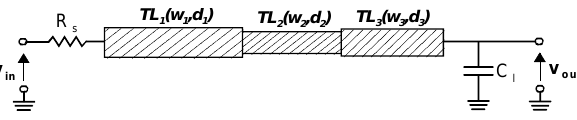
Figure 9: Microstrip lines in cascade.